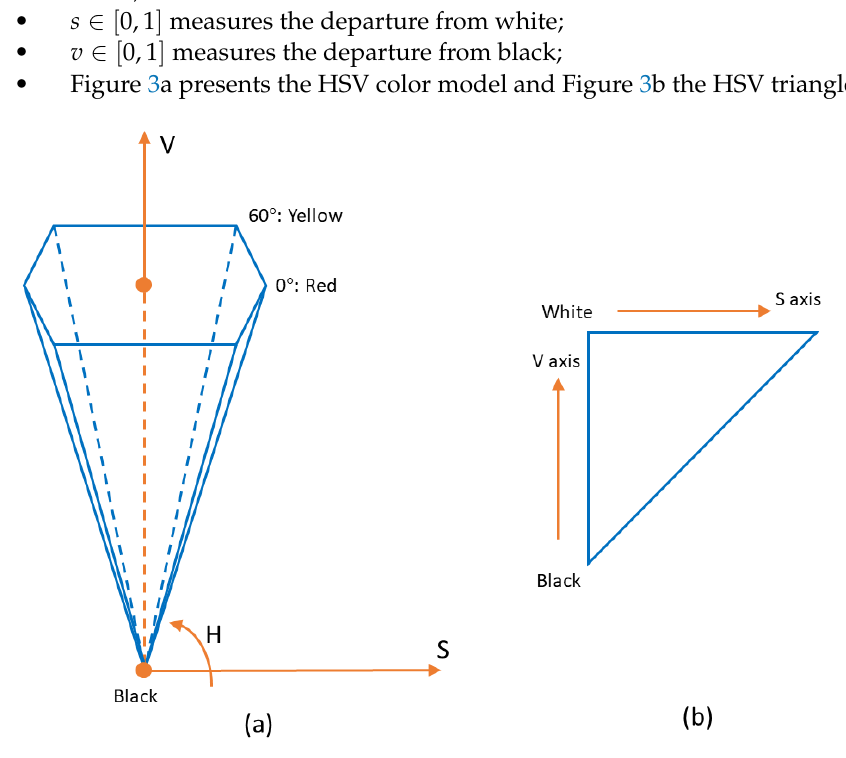
Figure 3. ( a ) HSV color model and ( b ) HSV